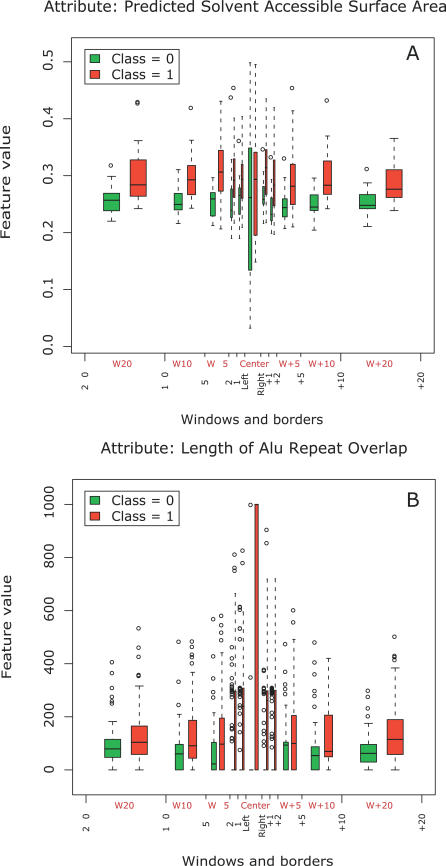
EpiGRAPH-Generated Diagrams Comparing Genomic Regions with Distinct Melting ProfilesDisplays boxplots comparing two genomic features between regions of high and low melting temperature (A) and flat and nonflat melting segments (B). Standard boxplots are drawn for the region itself and for ten windows surrounding the region, from −20 Kbp to +20 Kbp (x-axis), in order to capture neighborhood effects. The y-axis shows averages and distribution of the analyzed genomic feature. For each window, two boxplots are drawn, one for each class of melting profiles.(A) Regions are characterized by the extreme melting temperatures observed throughout the human genome. “Class 0” comprises 20 regions having low melting temperatures (below 50 °C in all cases), while “class 1” comprises 20 cases having high melting temperature (above 90 °C in all cases). Comparison with the average solvent-accessible surface area of the DNA (as predicted for each base pair using sequence trimers for which solvent accessibility has been established experimentally by the hydroxyl radical method [64]) shows that regions of high melting temperature exhibit substantially higher values than regions of low melting temperature. This is true not only for the region itself (center boxplot), but to a lesser extent also for its sequence neighborhood.(B) Regions are characterized by a flat/nonflat segmentation algorithm of the melting profile. “Class 0” contains 50 flat segments having an end-to-end step height of ±0.11 °C or less, while “class 1” contains 50 nonflat segments defined as having an end-to-end step height of ±6 °C or more. All segments were taken from Chromosome 21, exhibit an equal melting temperature of 68 °C and a segment length of 19 or 20 bps. Comparison with the average length of Alu repeat overlap per 1,000 base pairs (as identified by RepeatMasker) shows that flat regions are typically free of Alu repeats, while nonflat regions frequently exhibit substantial overlap with Alu repeats.